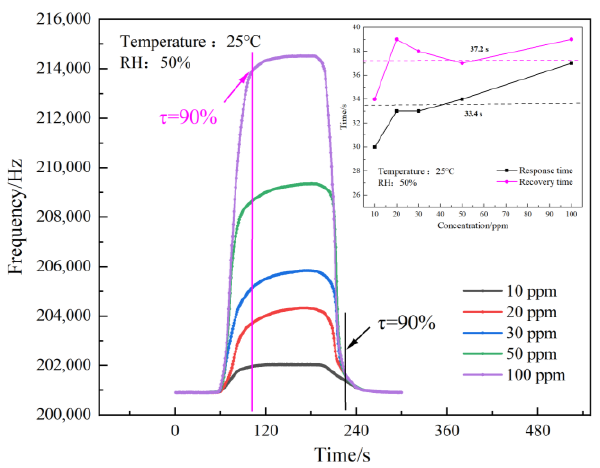
Figure 8. Response recovery time complex characteristic curve of the SAW sensor.